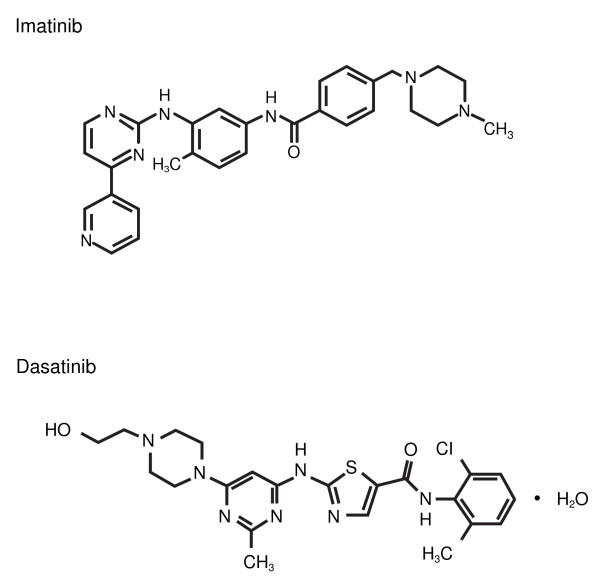
Chemical structures of imatinib (C29H31N7O) and dasatinib (C22H26C1N7O2S).